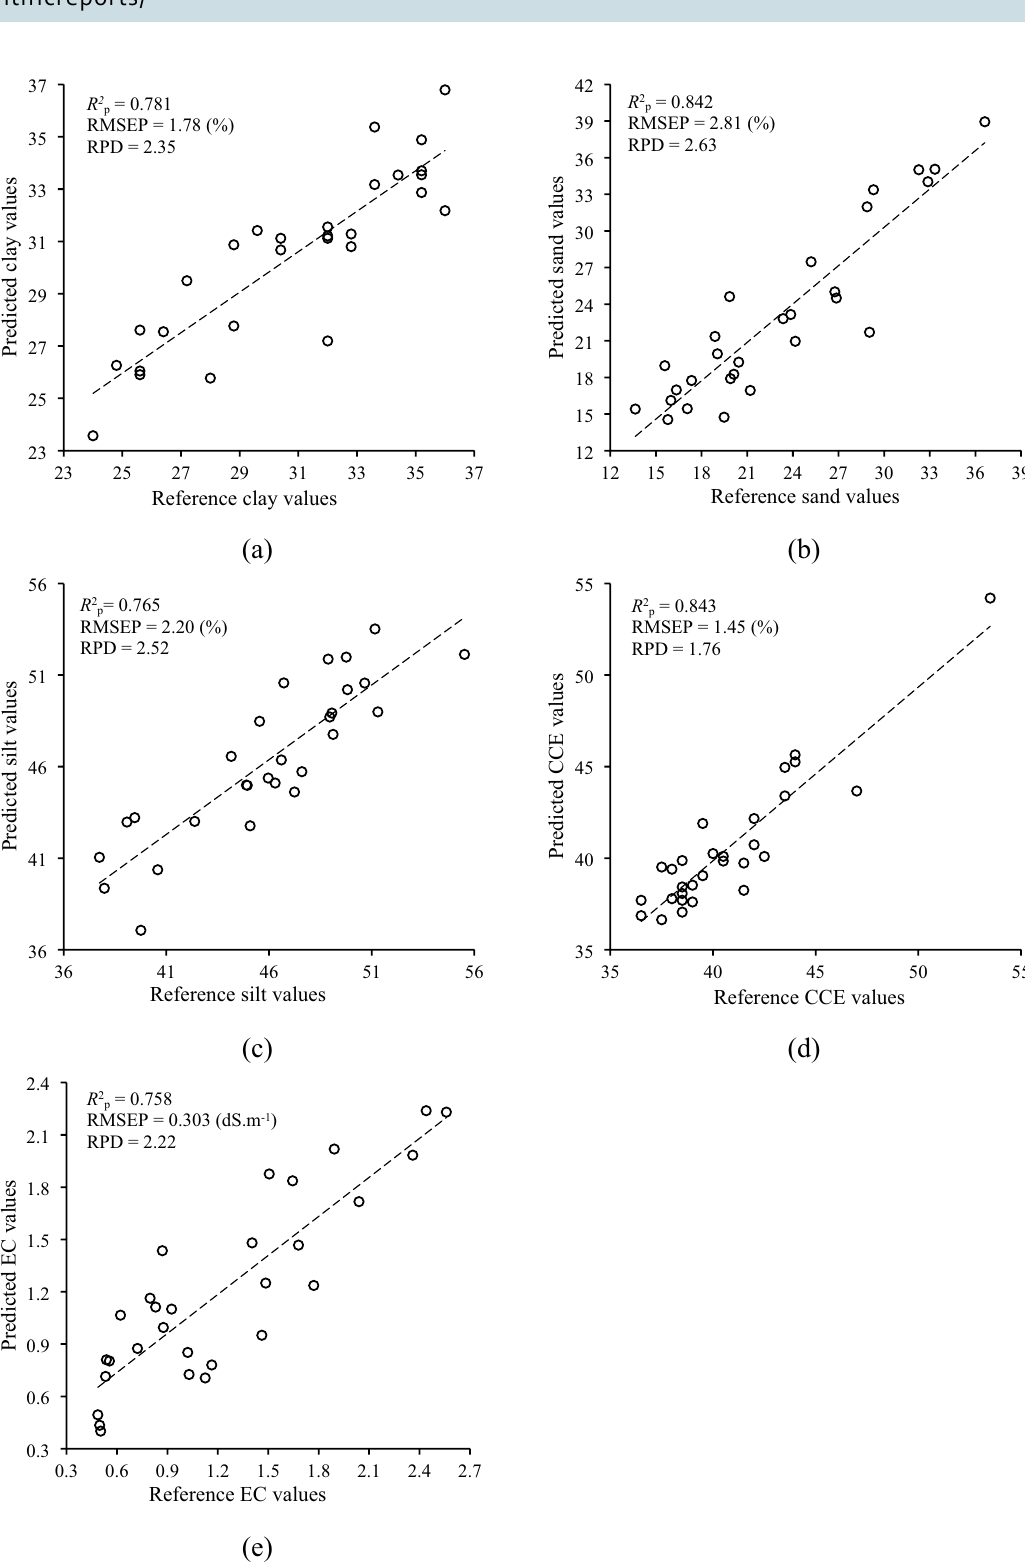
Figure 5. Estimated versus reference values obtained from the best ANN models of ( a ) clay and ( b ) sand using combination data of both spectrometers, and ( c ) silt, ( d ) calcium carbonate equivalent (CCE), and ( e ) electrical conductivity (EC) using spectral data of InGaAs